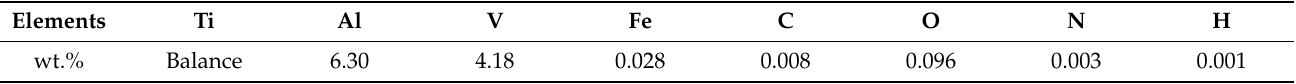
Table 1. Chemical composition of the Ti-6Al-4V particles